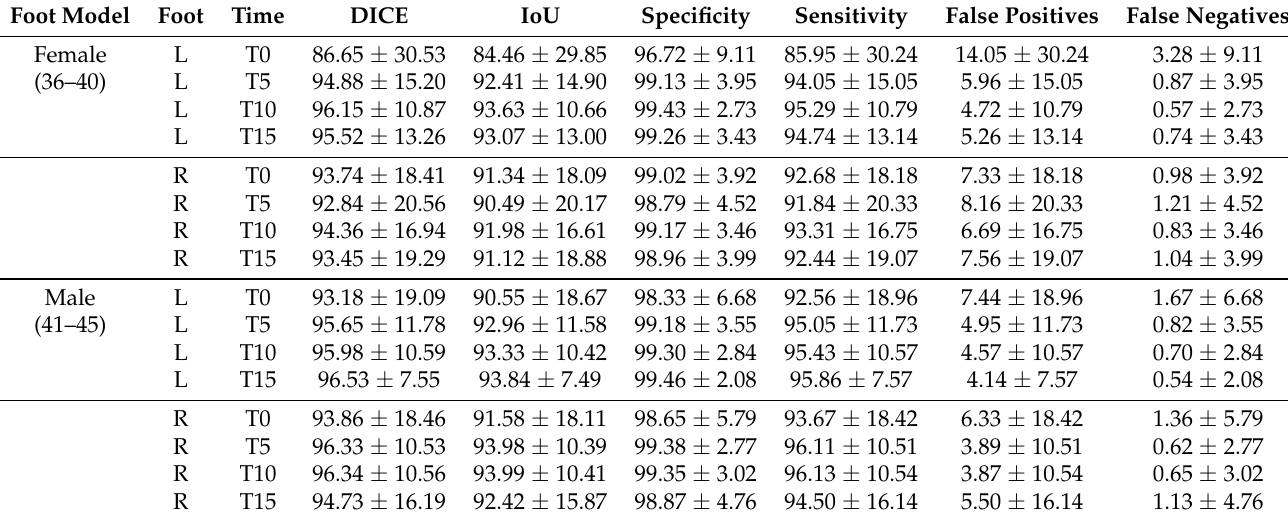
Table 2. Overlap measures at each time point for the extracted models associated with the right and left feet for female and male groups of subjects with a European foot size ranging between 36 and 40, as well as 41 and 45, respectively. Average values and their corresponding standard deviations are expressed as